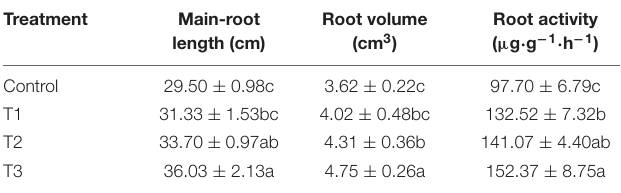
TABLE 2 | Effect of supplemental LED light duration on root parameters of cucumber.